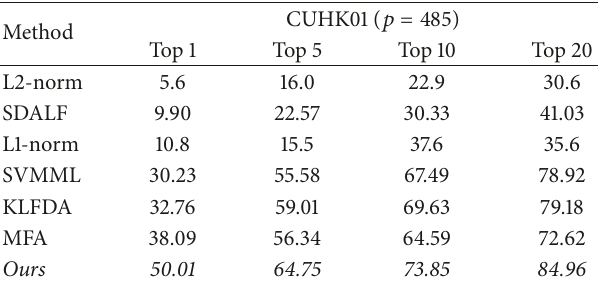
Table 7: Comparison of some other state-of-the-art results reported with CUHK01 database. The cumulative matching scores (%) at ranks 1, 5, 10, and 20 are listed.